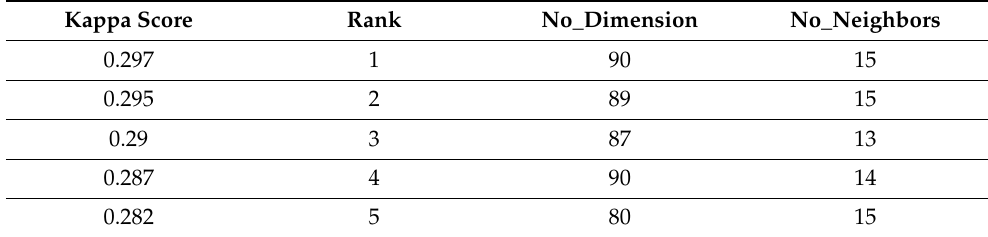
Table 2. The performance for models with different sets of values of the hyperparameters, no_dimension and no_neighbors, on training